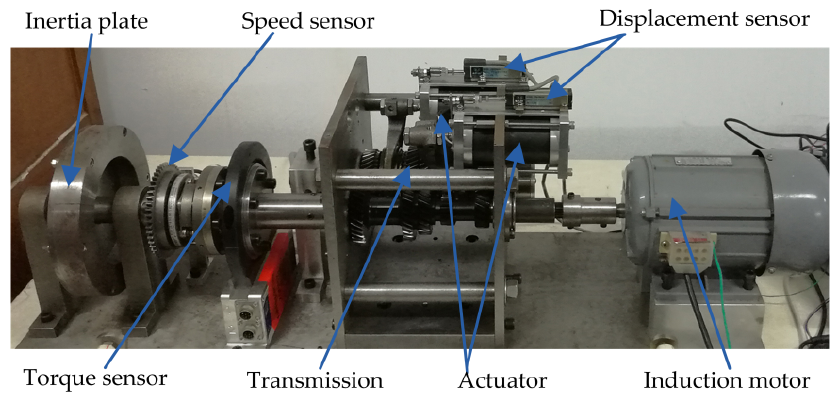
Figure 12. The experimental set up.